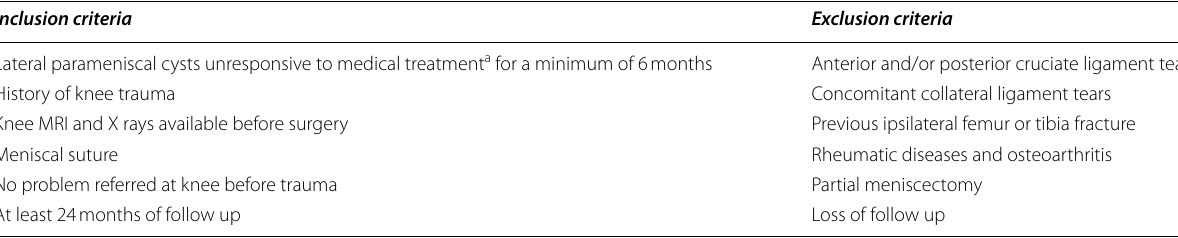
Table 1 Inclusion and Exclusion criteria Inclusion